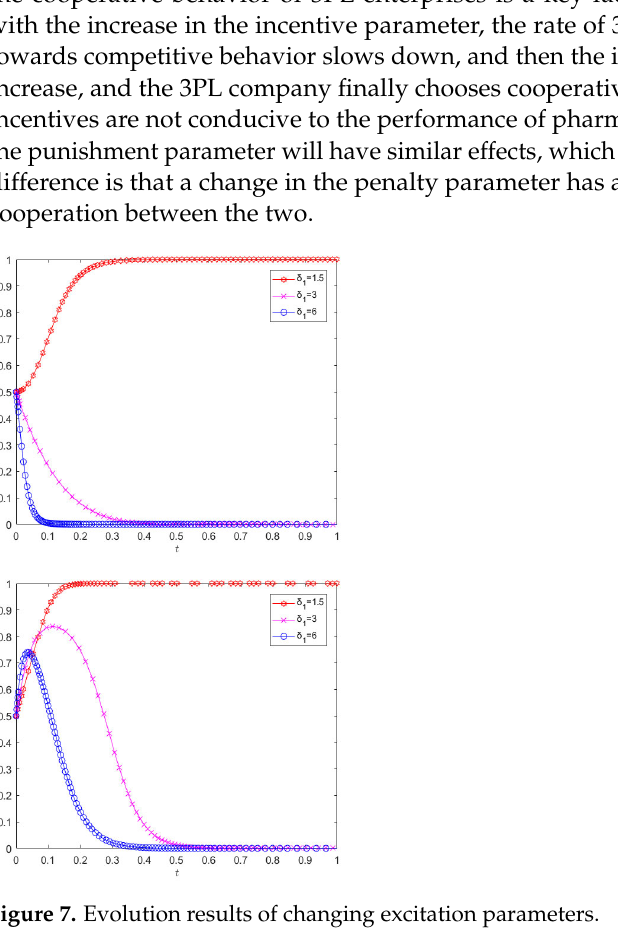
Figure 6. Evolution results of changing liquidated damages.